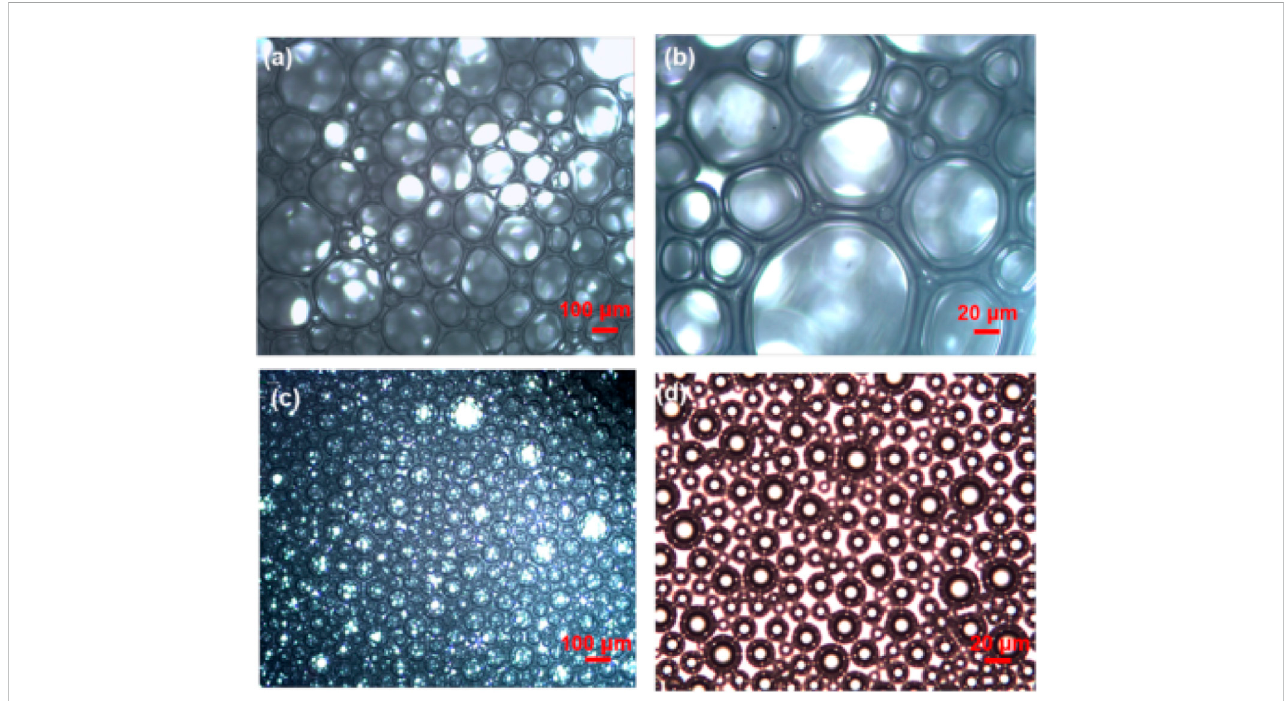
FIGURE 13 Morphology of conventional aqueous foam and foam-enhanced gel. (A) and (B) Conventional aqueous foam with only .3% surfactant; (C) and (D) foam gel (.3% surfactant + .3% comb polymer + .6% phenolic resin cross-linker) (Zhao et al.,